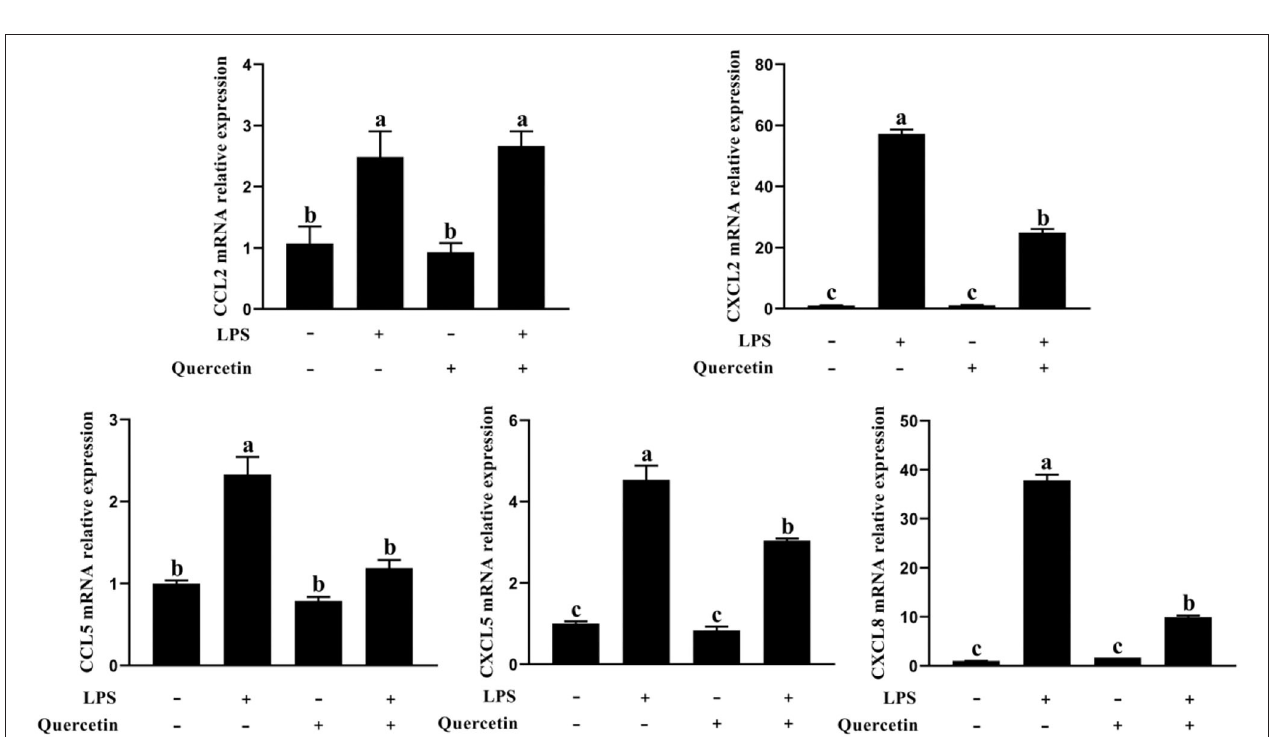
FIGURE 5 | Effects of quercetin on the mRNA expression of chemokines in LPS-induced BMECs. BMECs were treated with 100 µ g/ml of quercetin in the presence of 1 µ g/ml of LPS for 6h. The mRNA expressions of CCL2, CCL5, CXCL2, CXCL5, and CXCL8 in BMEC were assayed by qRT-PCR. Data presented are mean ± SEM ( n = 3). Different lowercase letters in the bar chart indicate significant differences ( P <